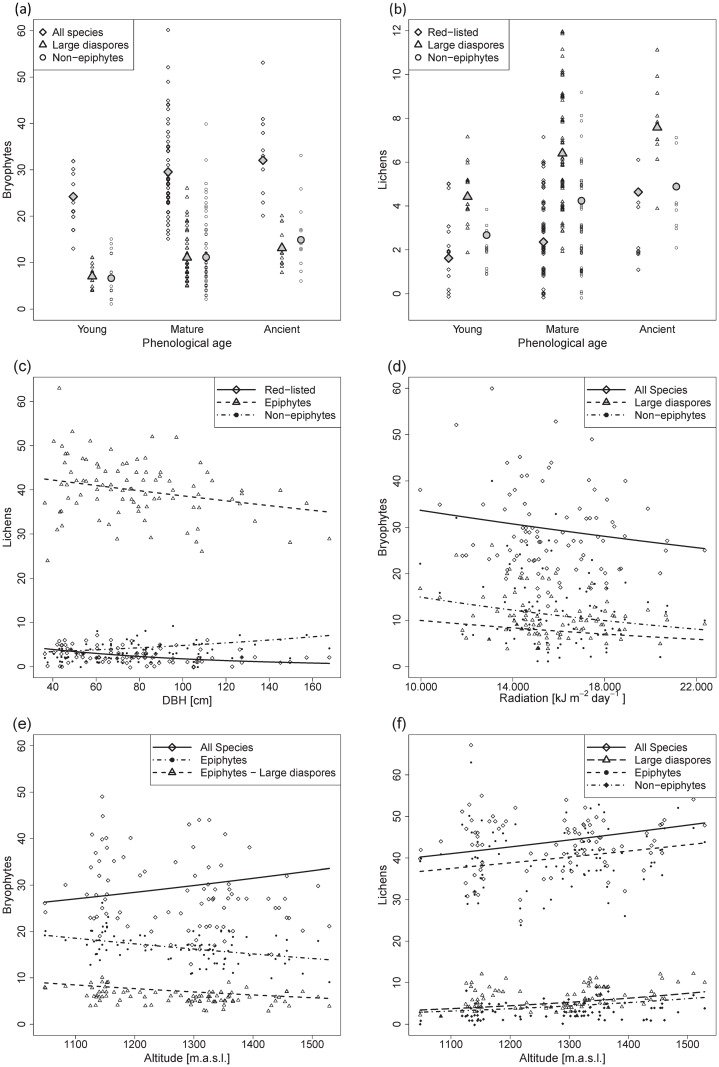
Effects of tree characteristics and environmental variables on epiphyte richness.Effect plots for significant (p < 0.05, significance levels according to GLMM analyses; see Table 4) and marginally significant (p < 0.1) relationships between (a-b) phenological age, (c) diameter at breast height (DBH), (d) radiation and (e-f) altitude and per tree richness of bryophytes and lichens. Large symbols and regression lines represent the estimated values for the population mean, small symbols represent the observations, i.e., the richness on each sampled tree.